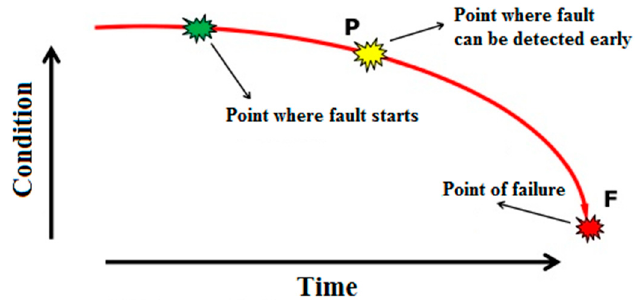
Figure 2. Scheme of a laminator containing around 50 rollers (courtesy of Tetra Pak).